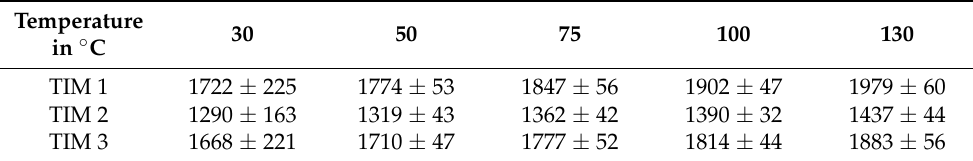
these measurements are given in Table 4. The uncertainty was reported for a confidence level of C = 95%. Table 4. Specific heat capacity of all investigated TIMs in J/(kgK).